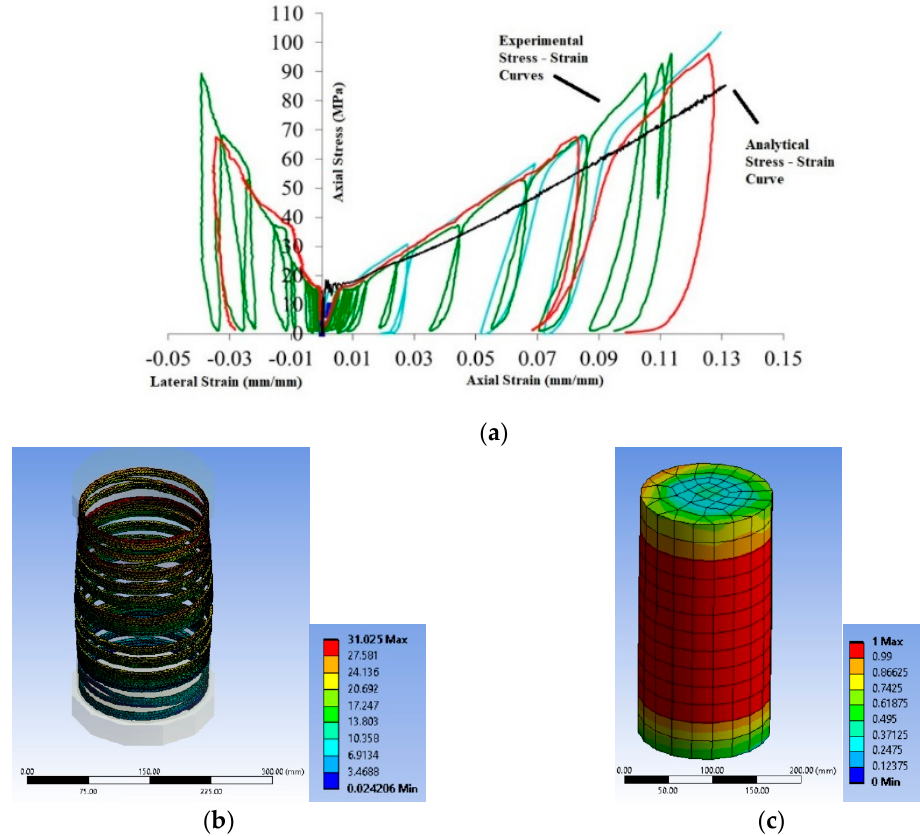
Figure 18. ( a ) Experimental vs. analytical stress-strain curves for columns of the VinL1v1 group wrapped with one full layer of Vinylon Fiber Ropes (VFR); ( b ) deformation of composite ropes for column VinL1v1 and ( c ) variation of damage of the concrete core for columns VinL1v1.